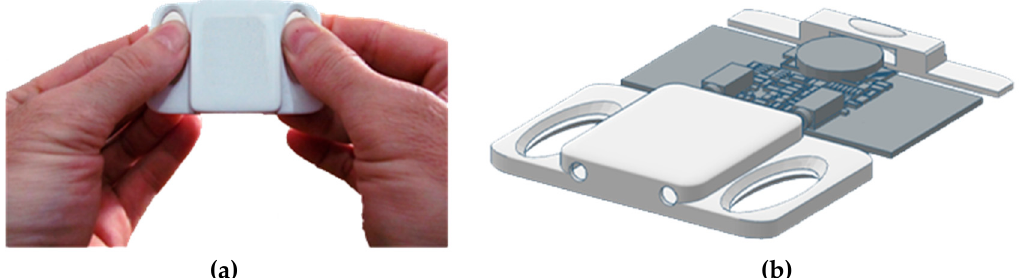
Figure 4. Mobile ECG sensing extender, usage and design by ECG for everybody: ( a ) its size compared with the fingers; ( b ) its interior with the plastic cover removed.